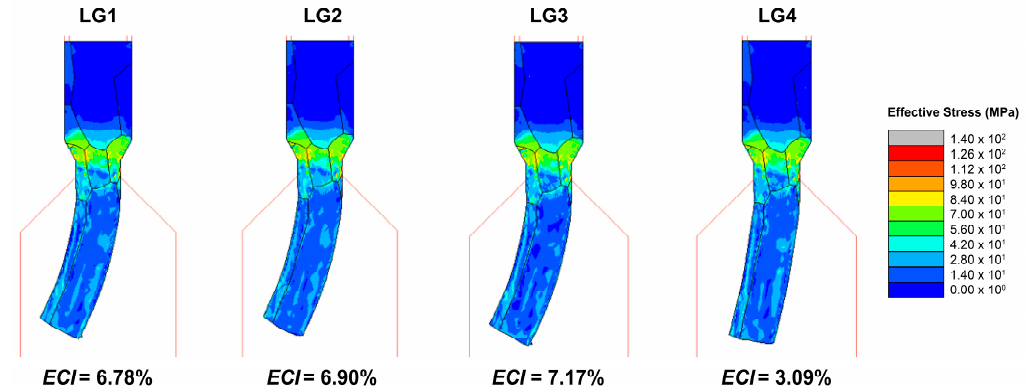
Figure 17. The micro-extrusion results of the considered conditions (LG1–LG4).